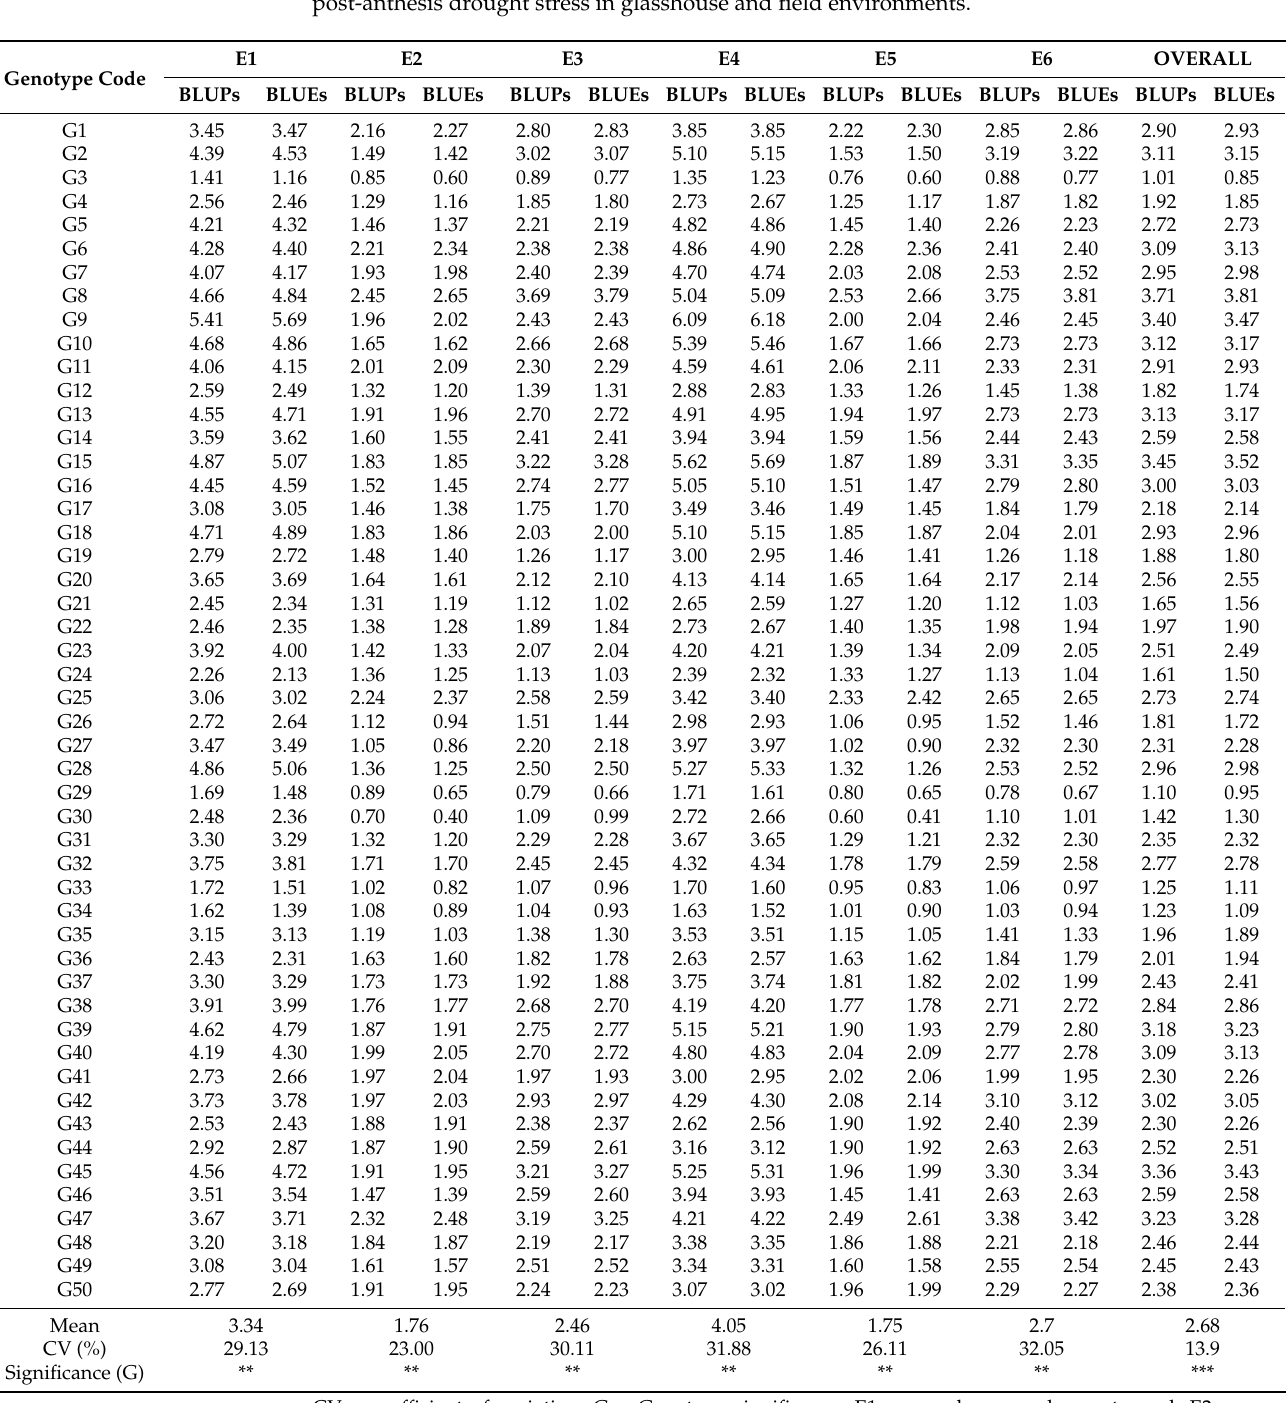
Table 2. Best linear and unbiased predictions (BLUPs) and best linear and unbiased estimates (BLUEs) for grain yield of 225 sorghum genotypes evaluated under non-stress conditions, pre- and post-anthesis drought stress in glasshouse and field